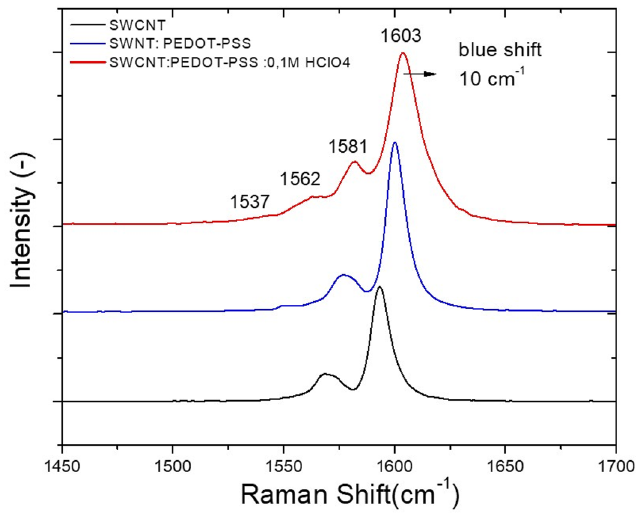
Figure 4. Raman spectra for SWNTs (black line), PEDOT-SWNTs (blue line), SWNTs-PEDOT + (0.1 M) HClO 4 (red